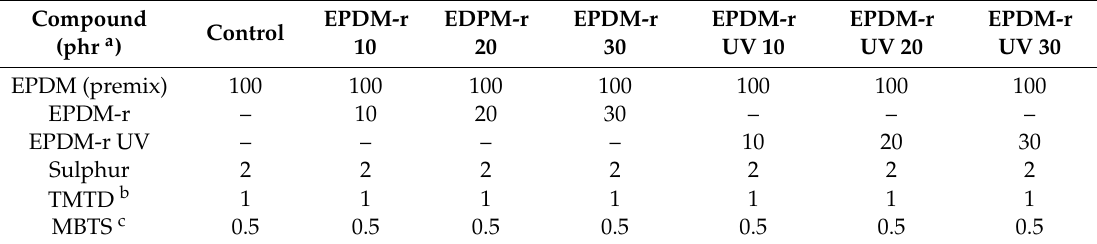
Table 1. Recipes of the analyzed samples. Blends contained di ff erent concentrations of the recycled ethylene–propylene–diene monomer rubber (EPDM) before (EPDM-r) and after aging by UV (EPDM-r